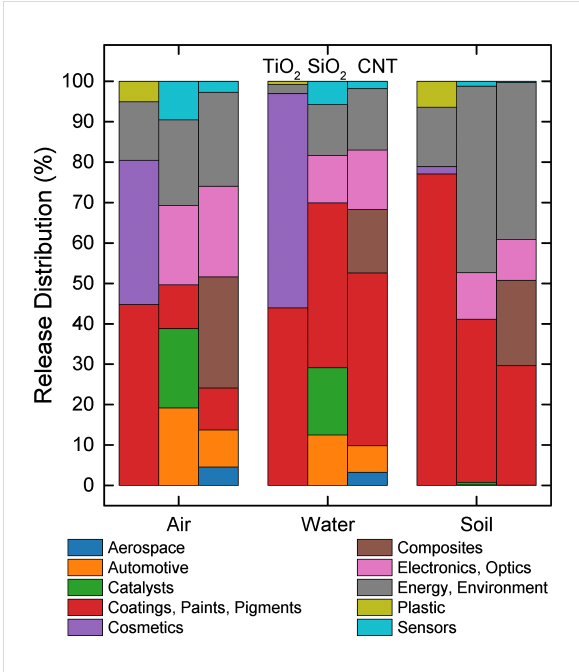
Figure 14: Apportionment of environmental release rates of selected ENMs to specific compartments in the Los Angeles region to different ENM